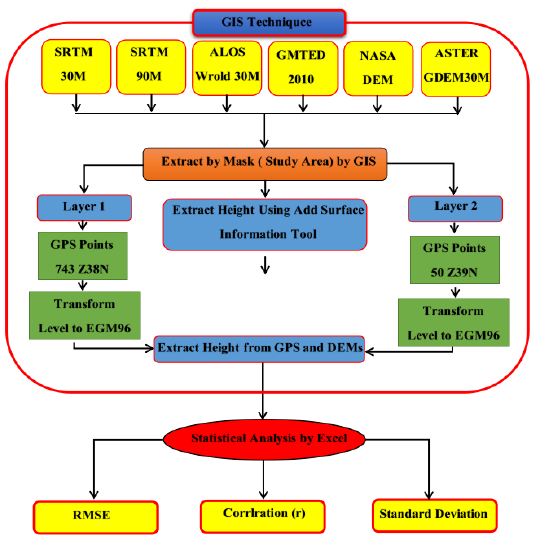
Figure 8. Flowchart for used methodology.